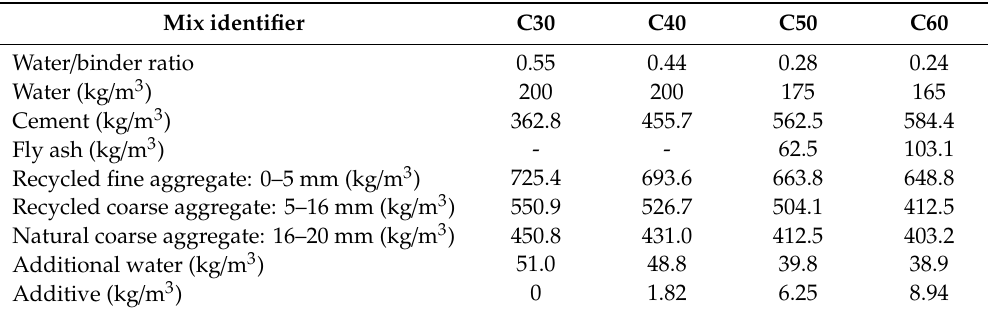
Table 3. Mix proportion of composite-recycled aggregate concrete